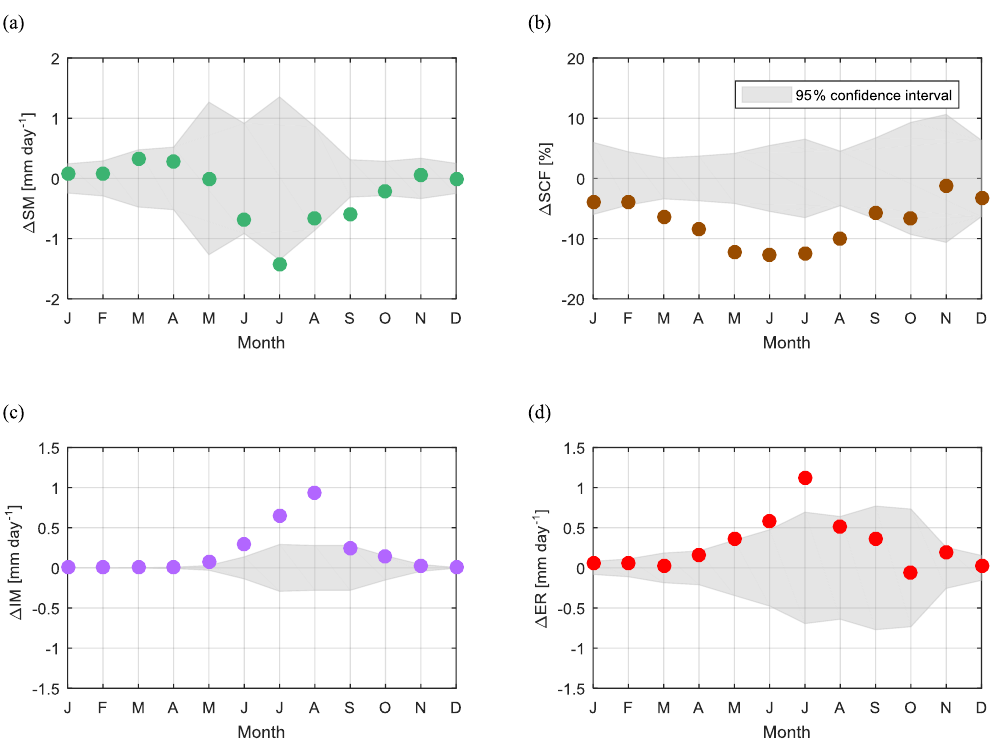
Figure 9. Mean monthly differences (between 1987–2015 and 1975–1986) in variables (a) snowmelt SM, (b) snow-cover fraction SCF, (c) ice melt IM, and (d) effective rainfall ER. Points outside the confidence interval (grey shaded area) represent statistically significant (5% significance level) changes in the monthly mean.